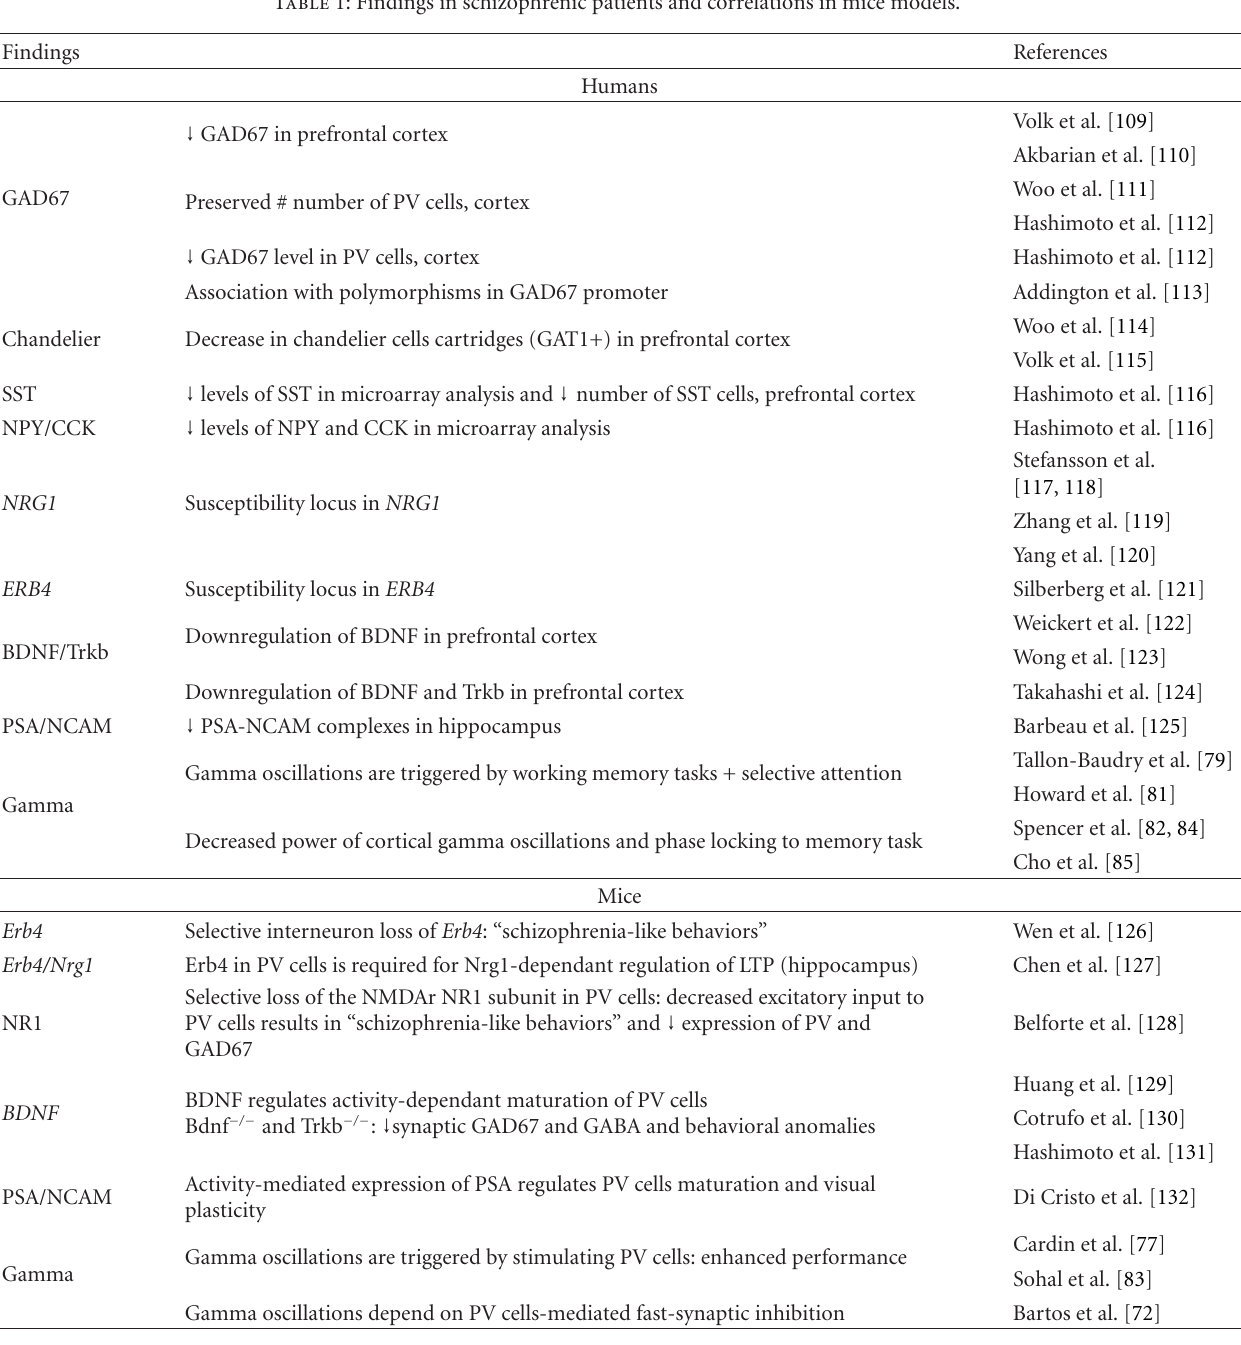
Table 1: Findings in schizophrenic patients and correlations in mice